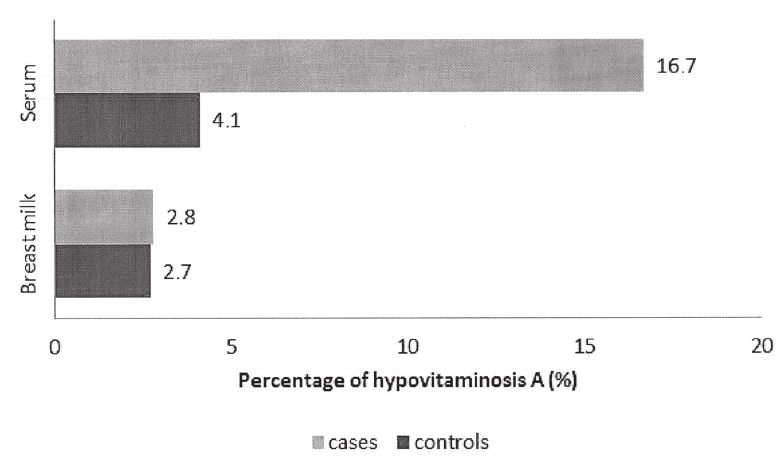
Figure 2 - Percentage of hypovitaminosis A in maternal serum and breast milk in studied